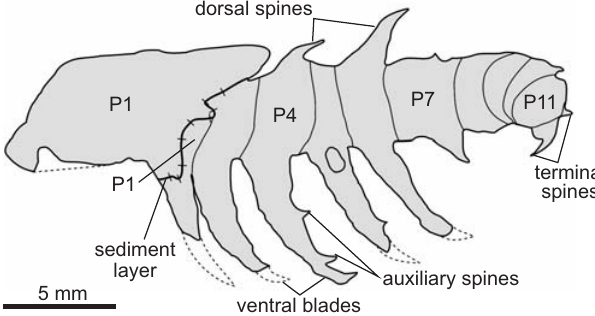
), cross polarized light (A ), cross-polarized light, red and yellow channels enhanced (A 2 3 ), black and white (B ). 1 2